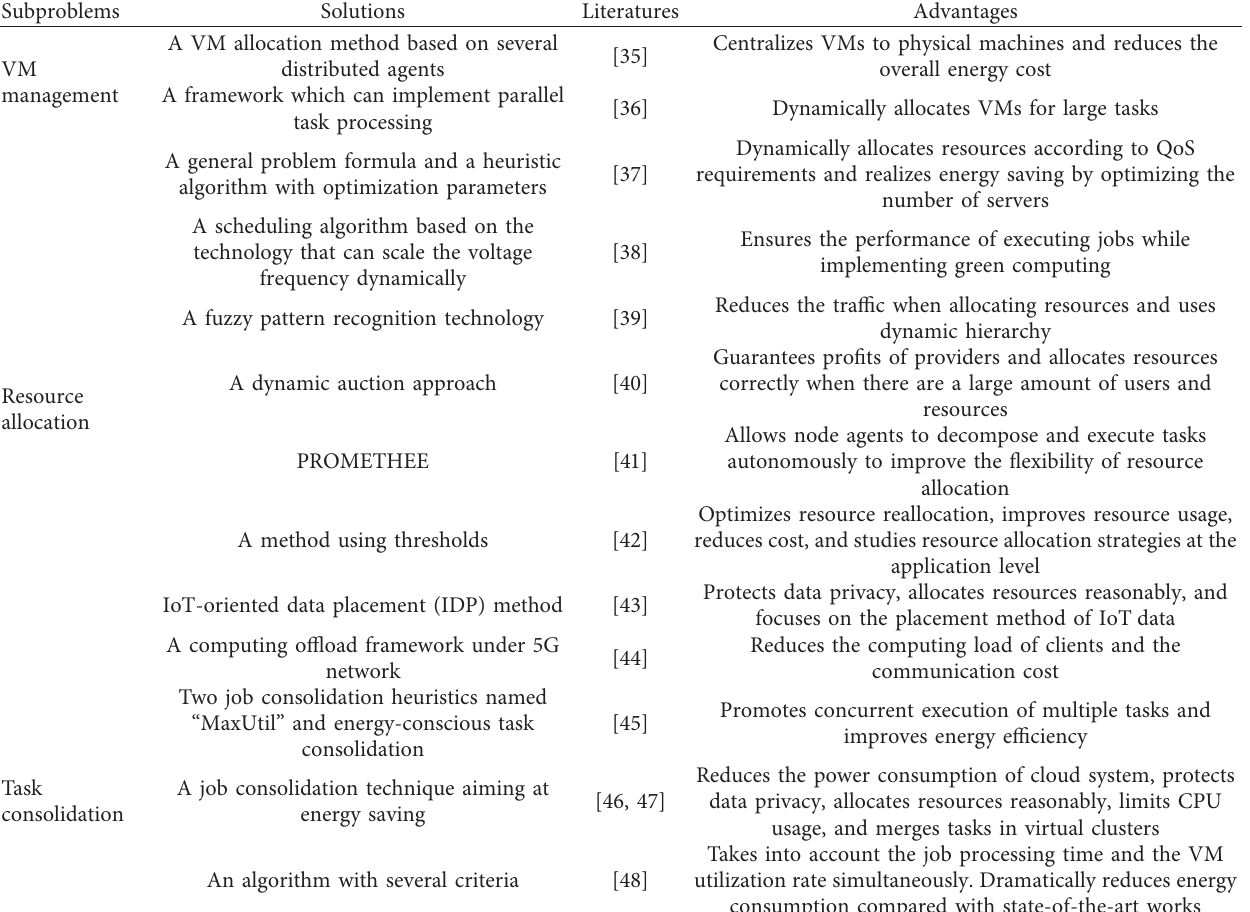
Table 2: Work summary of resource allocation and management in cloud